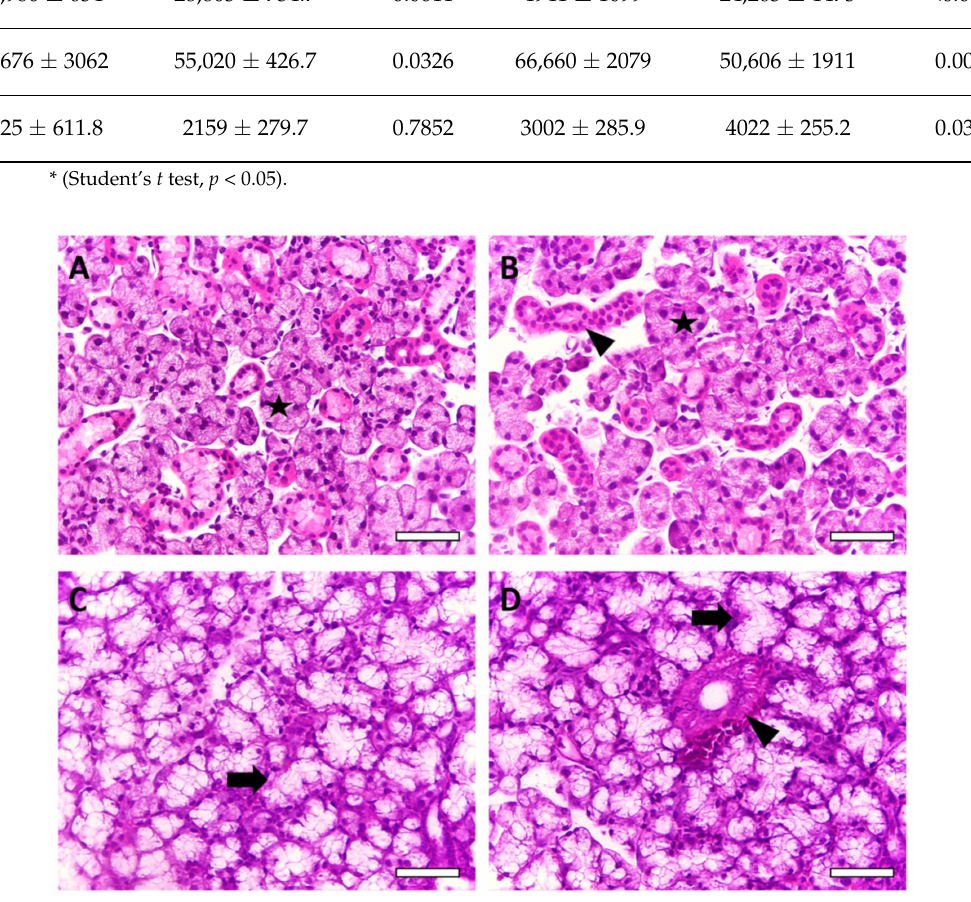
Figure 4. Effects of long-term AlCl 3 exposure (8.3 mg/kg/day) on rat salivary glands. Representative photomicrographs of ( A ) control and ( B ) aluminum parotid glands and ( C ) control and ( D ) alu- minum submandibular glands. Stars indicate serous acinus; arrows indicate mucous tubulous and arrowheads indicate ducts. The sections were stained with hematoxylin and eosin (H&E). Scale bar = 50 µ